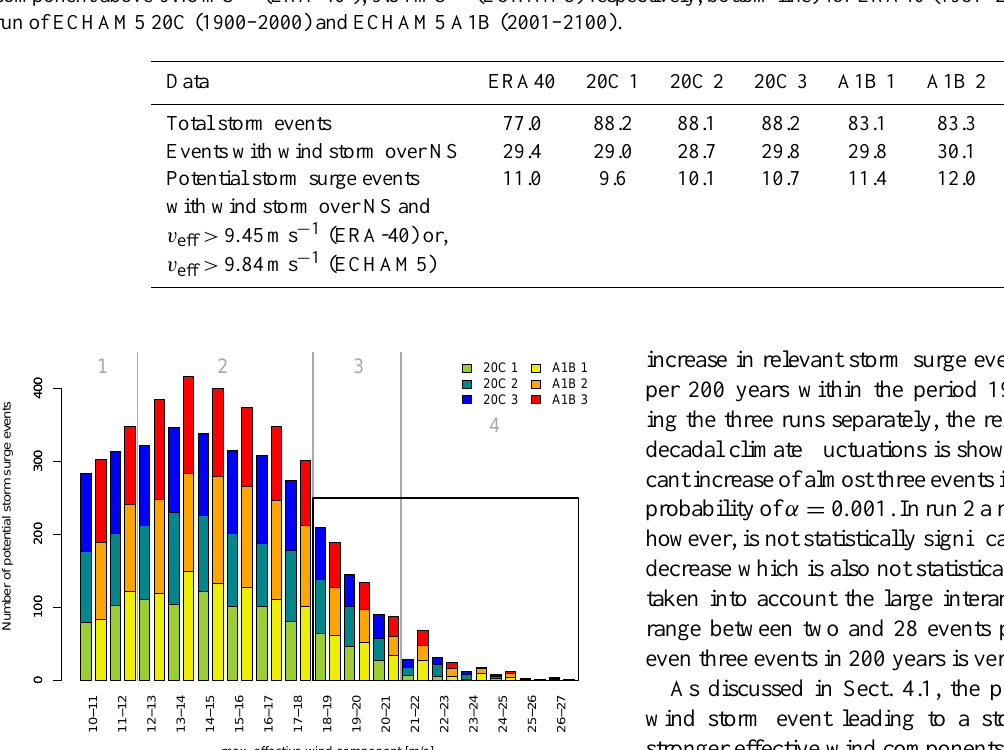
Table 1. Mean number of events per year within the whole identification area (top line), events with at least one time step within the North Sea (NS) region (middle line) and the amount of potential storm surge events (large-scale wind storm affecting North Sea region + effective wind